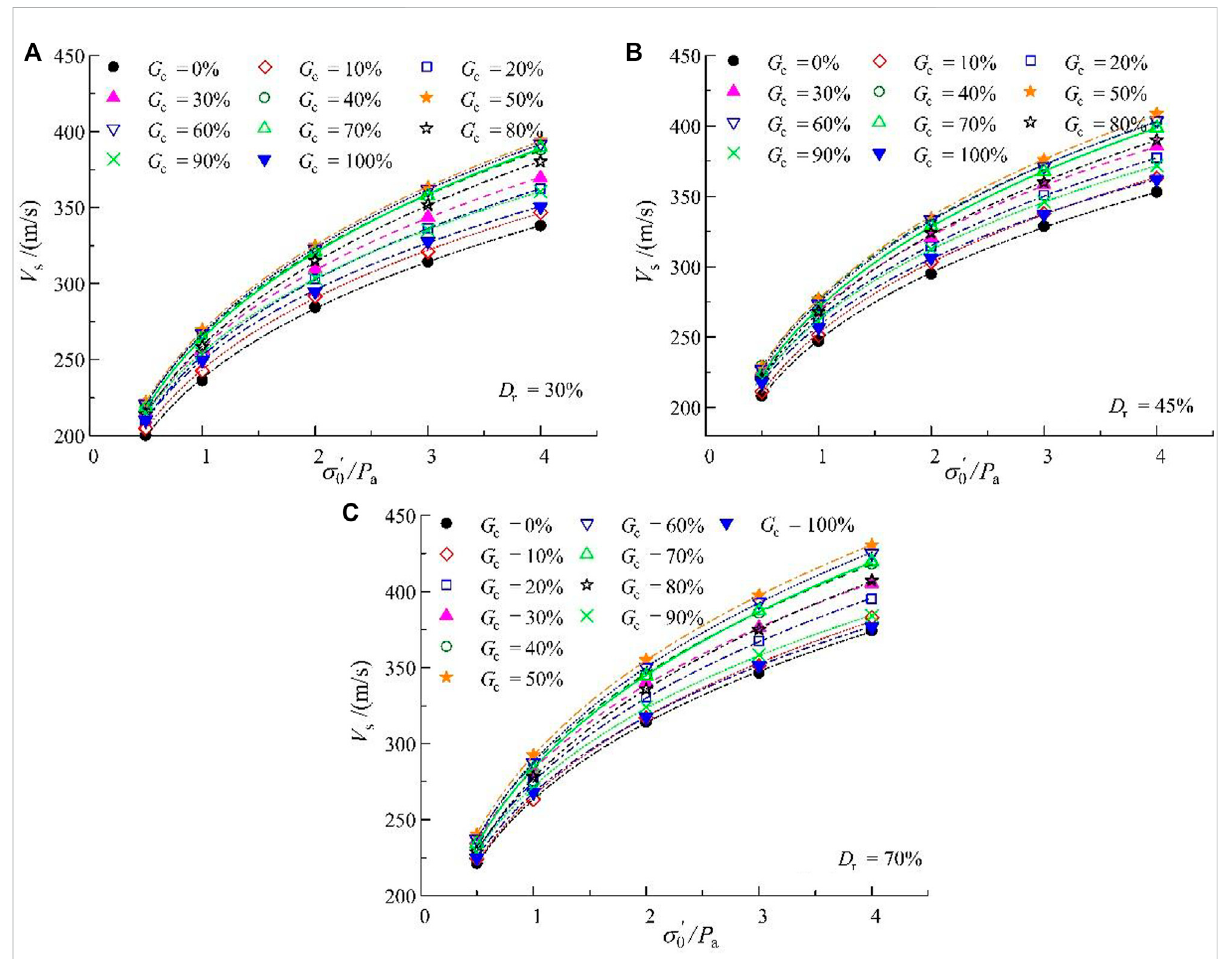
FIGURE 4 Relationship between the normalized effective con fi ning pressure and V s of the sand-gravel mixtures: (A) D r = 30% (B) D r = 45% (C) D r =